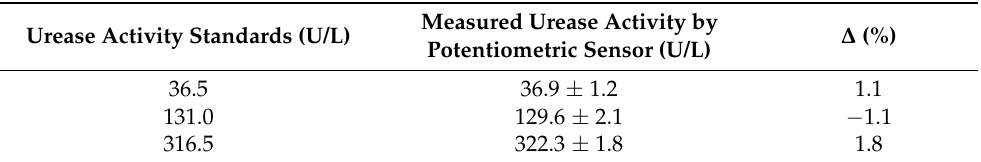
Table 3. Urease activity in laboratory samples determined by six GC/PAz/ISM I potentiometric sensor, with n = 3 repetitions. Urease Activity Standards